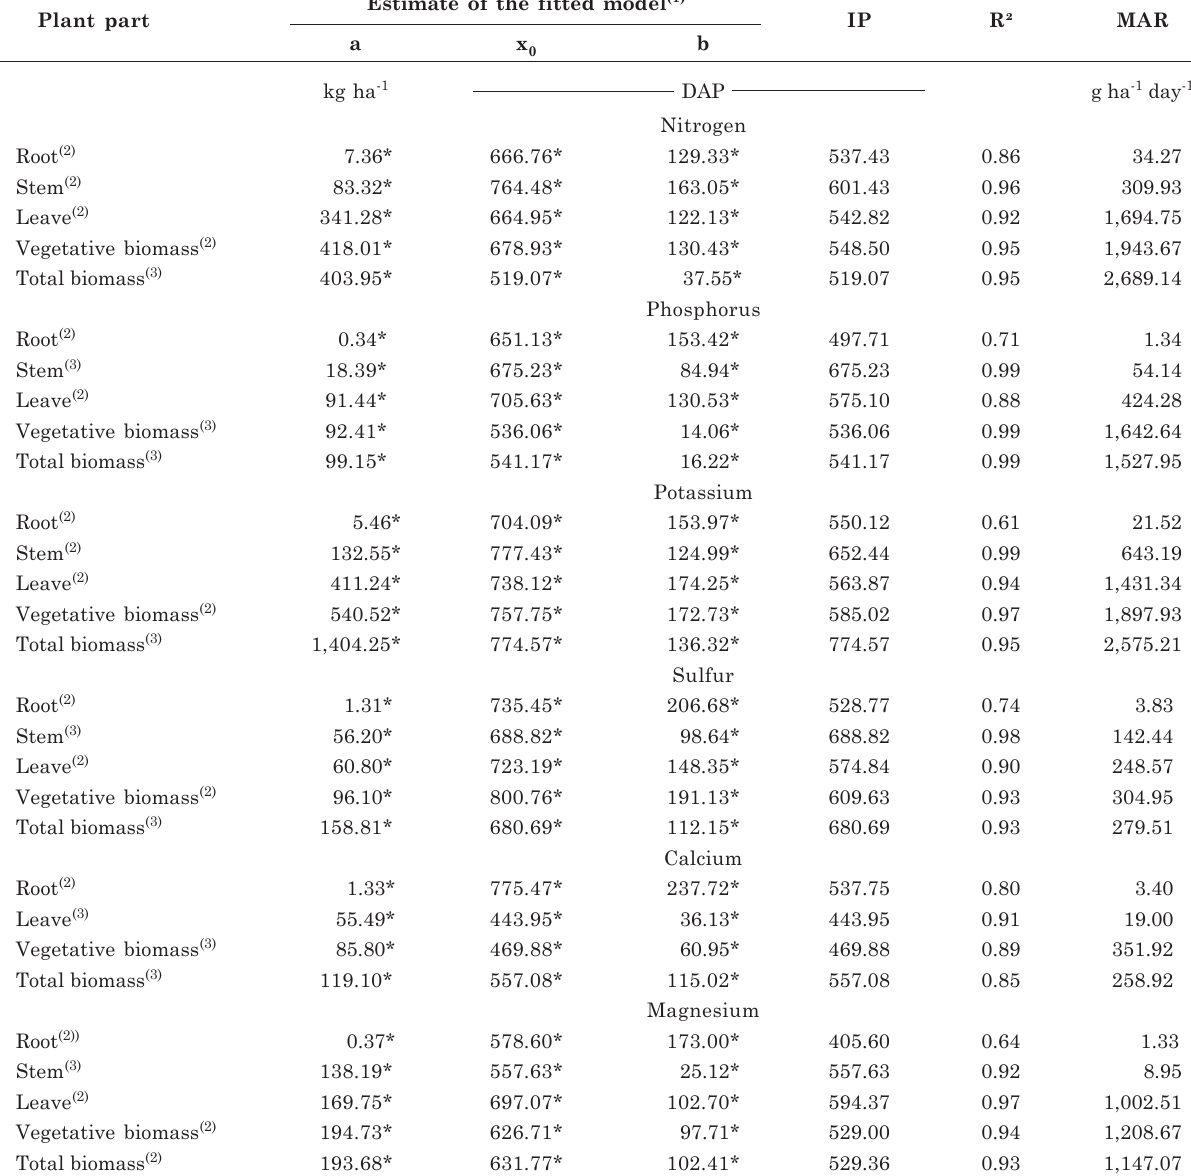
Table 1. Estimate of the parameters of the fitted non-linear regression model and maximum accumulation rate (MAR) of macronutrients in the plant components: roots, stem, leaves, vegetative biomass, and total biomass during the development cycle of the ‘Vitória’ pineapple plant. Inflection point (IP)